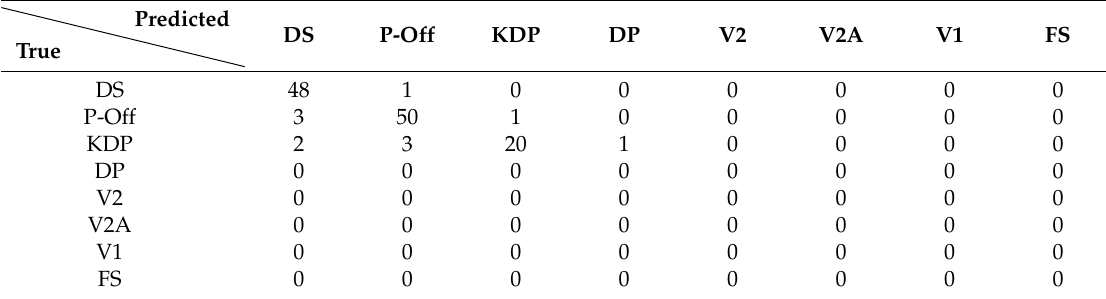
Table A3. Confusion matrix for the flat course, classical style validation set of skier 2 when using the sports biomechanics configuration of